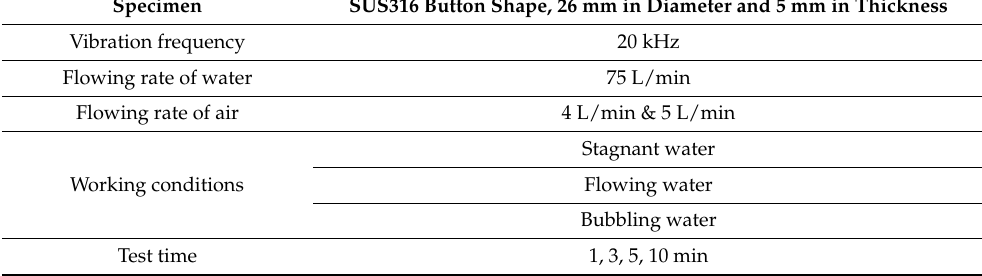
Table 1. Experimental